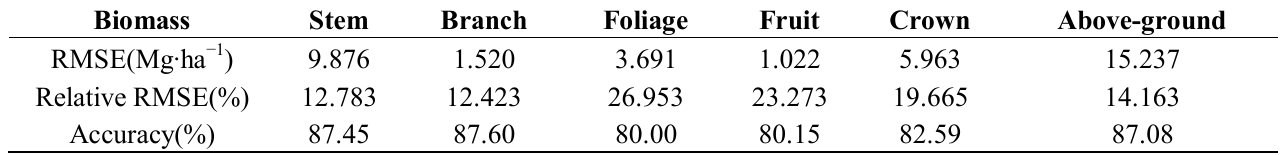
3. Estimated accuracy of above-ground biomass and individual biomass components; RMSE : root mean squared